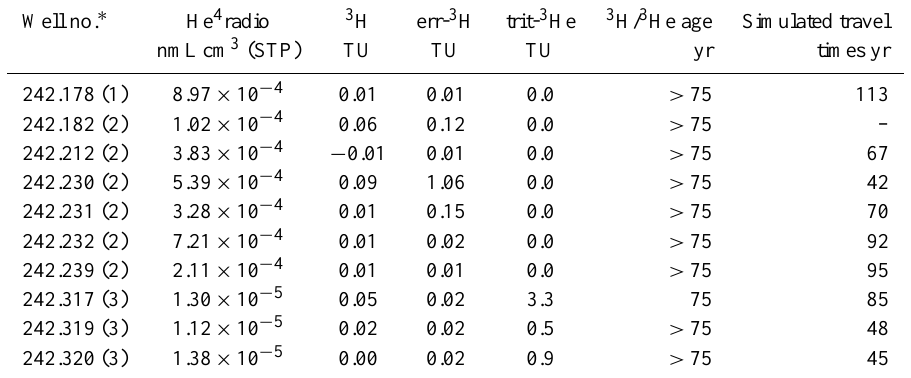
Table 9. Measured 3 H/ 3 He values and estimated 3 H/ 3 He groundwater ages compared to model-simulated travel times in supply wells. Well no. ∗